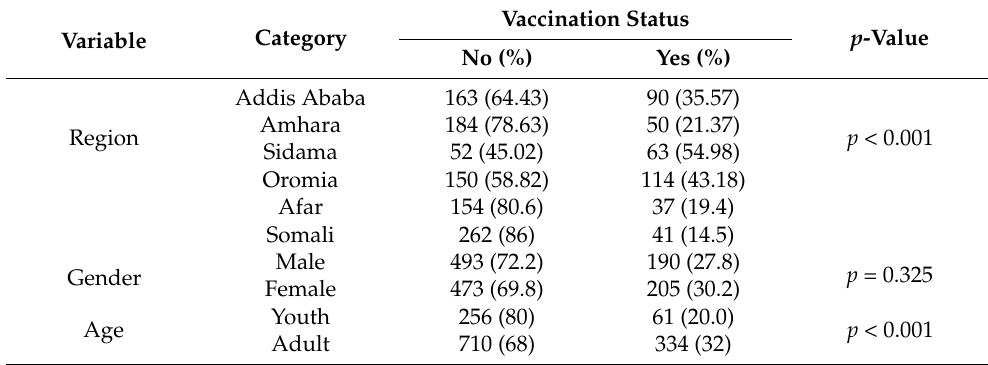
Table 7. The level of COVID-19 vaccination status by region, sex, and age regarding COVID-19 prevention attitudes at the time of the COVID-19 hesitancy baseline survey in Ethiopia,